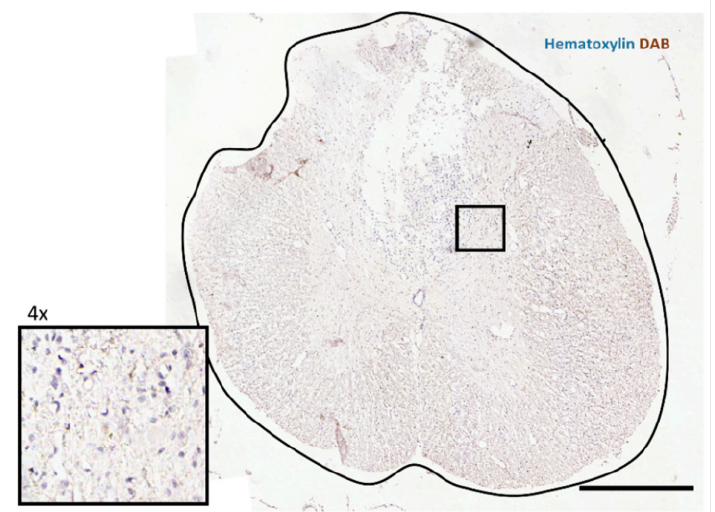
Figure A1. Negative control of immunohistochemical staining. Section of spinal cord with lesion was stained according to the protocol described in Section 2, while leaving out the primary antibody. Scale bar: 500 µ m.